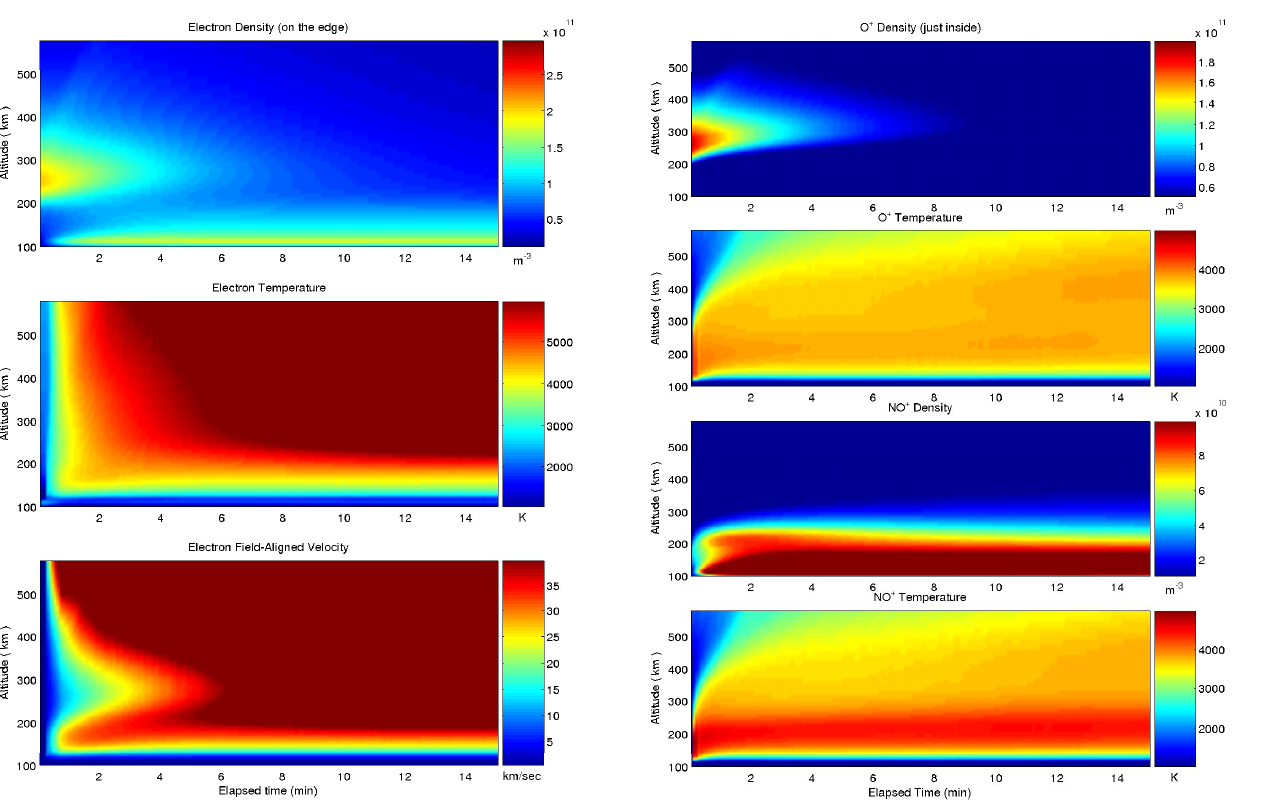
Fig. 10. Time evolution of ion parameters just inside the precipita- tion zone, where E -region conductivities reach their largest